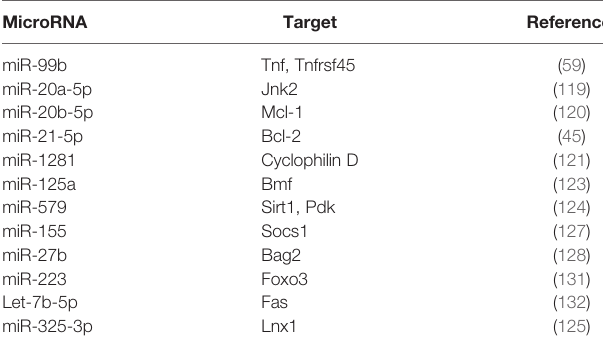
TABLE 2 | MicroRNAs involved in the regulation of apoptosis during M. tuberculosis infection.